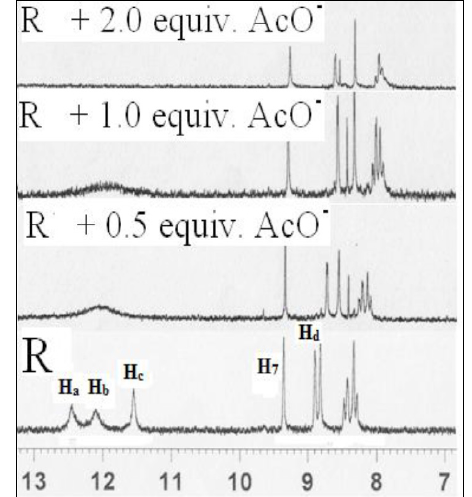
1 H NMR spectrum of R 34 in DMSO- d6 with Figure 28: Partial addition of different equiv of TBAA. (adapted from ref. 71e).